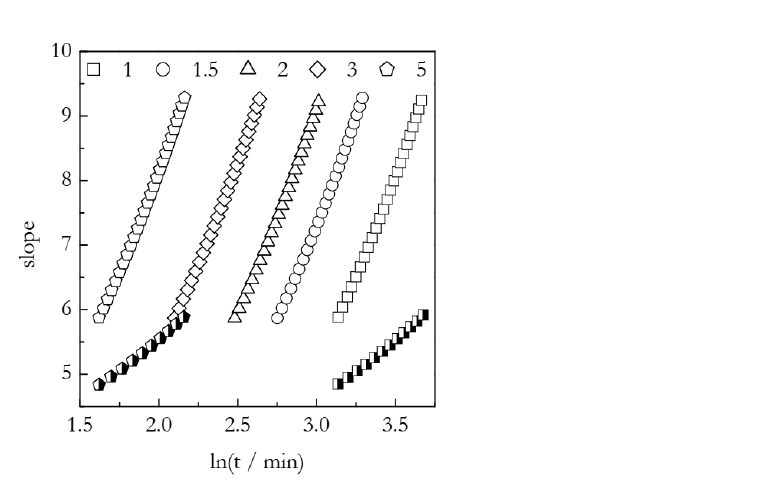
Figure 3. Theoretical slope values estimated for the simulated nonisothermal data. Open symbols for Equation (18), semi-solid symbols for Equation (9). Numbers by the symbols are heating rates in K min − 1 .